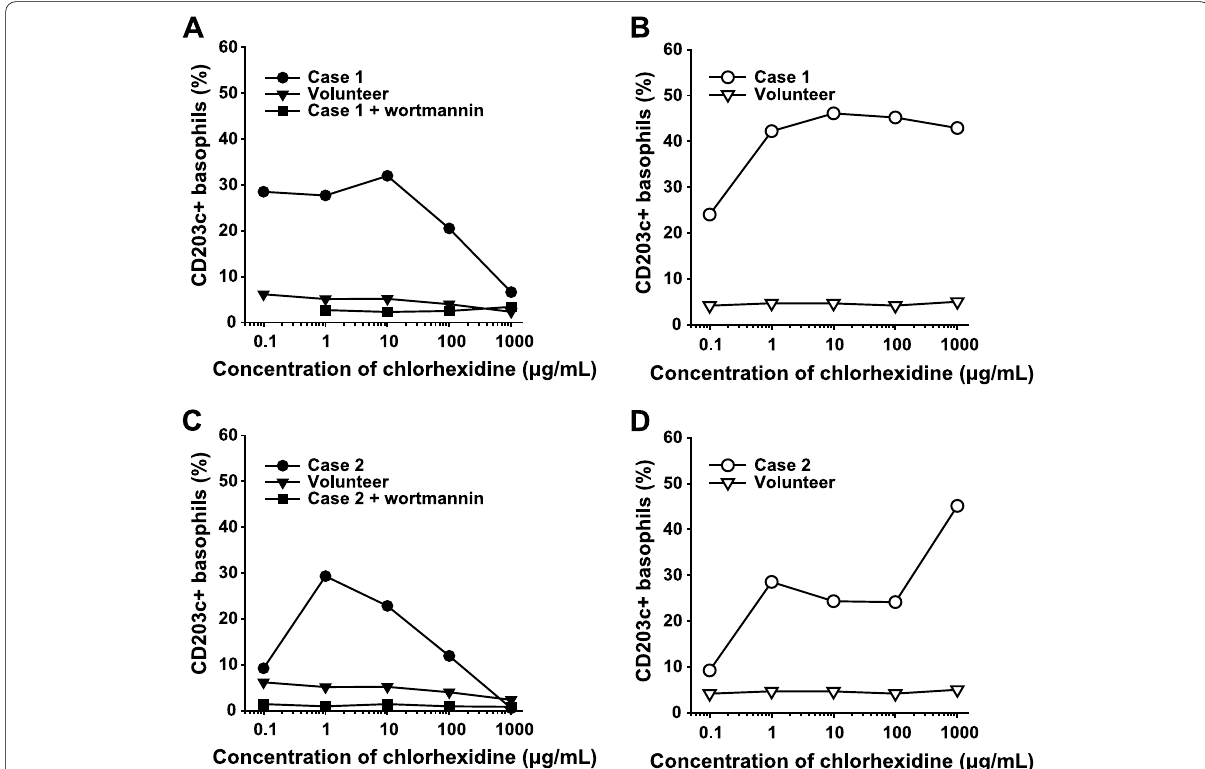
Fig. 1 Results of basophil activation tests with CD203c. A Chlorhexidine (Hexak ® ) induced CD203c upregulation in case 1 (filled circles), but not in a volunteer (filled triangles). Wortmannin significantly suppressed chlorhexidine-induced CD203c upregulation (filled rectangles). B Chlorhexidine (Stericlon ® )-induced CD203c upregulation in the patient (open circles), but not in a volunteer (open triangles). C Basophil activation tests in case 2 show similar results to A . D Basophil activation tests in case 2 show similar results to